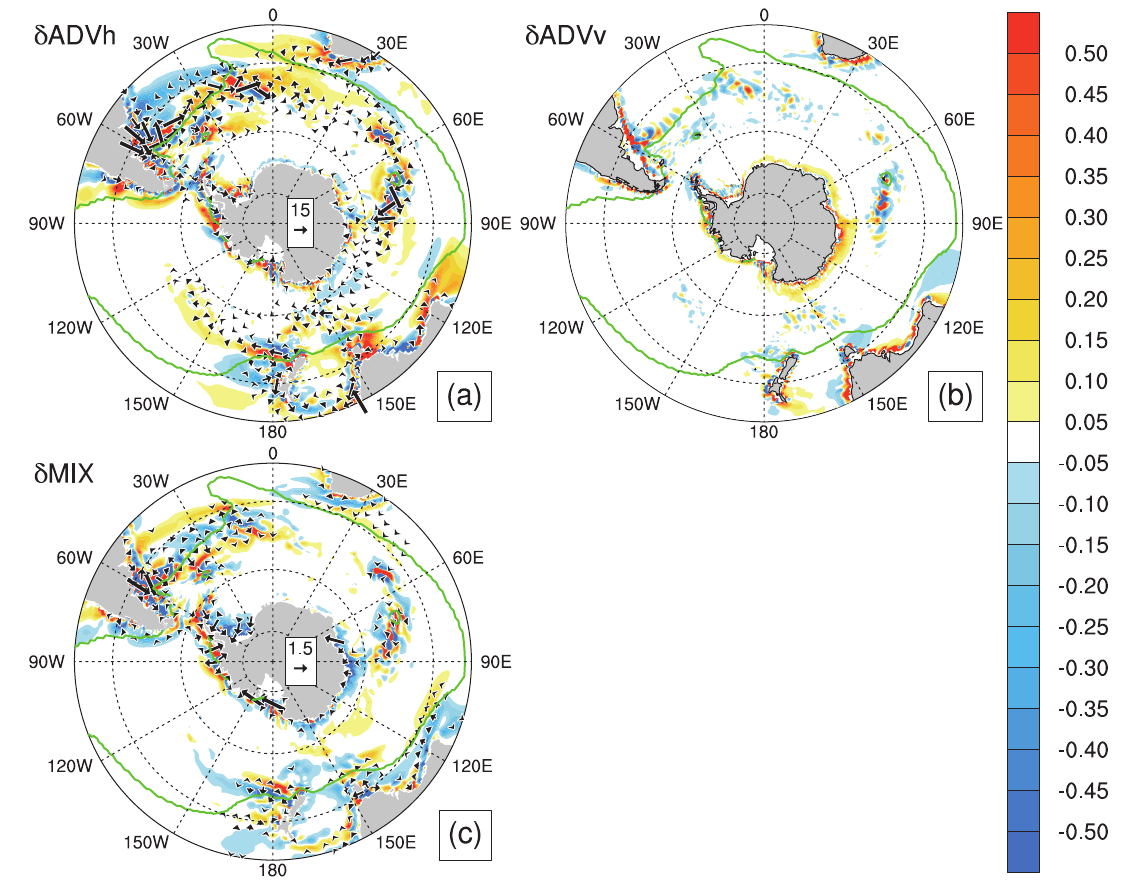
Fig. 11. The same as Fig. 10a–c, but showing the difference between the 2090s and 1990s (a–c)